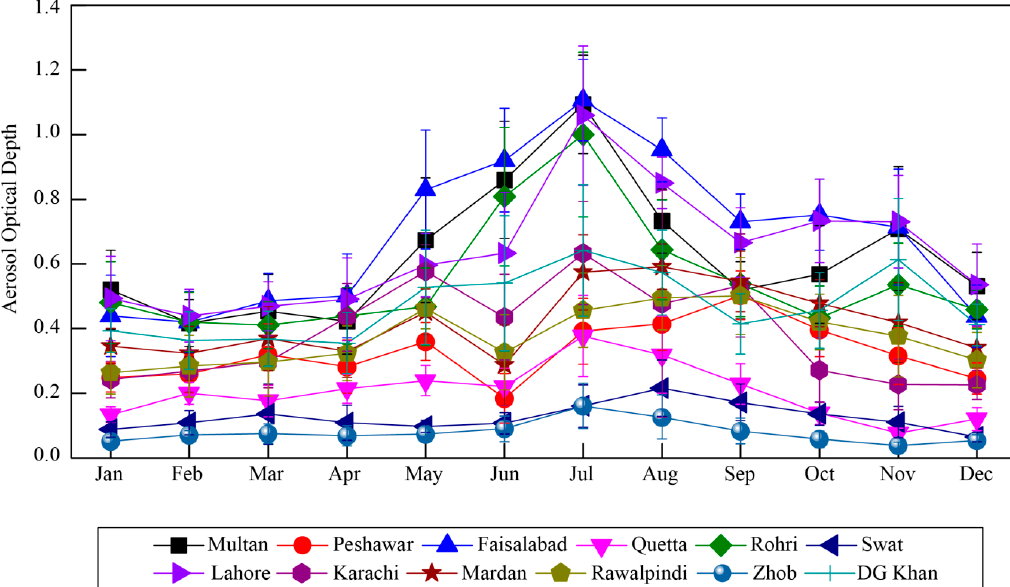
Figure 3. The annual cycle of MODIS AOD over the selected regions between 2003 and 2017. The vertical bars represent standard deviation from the mean.